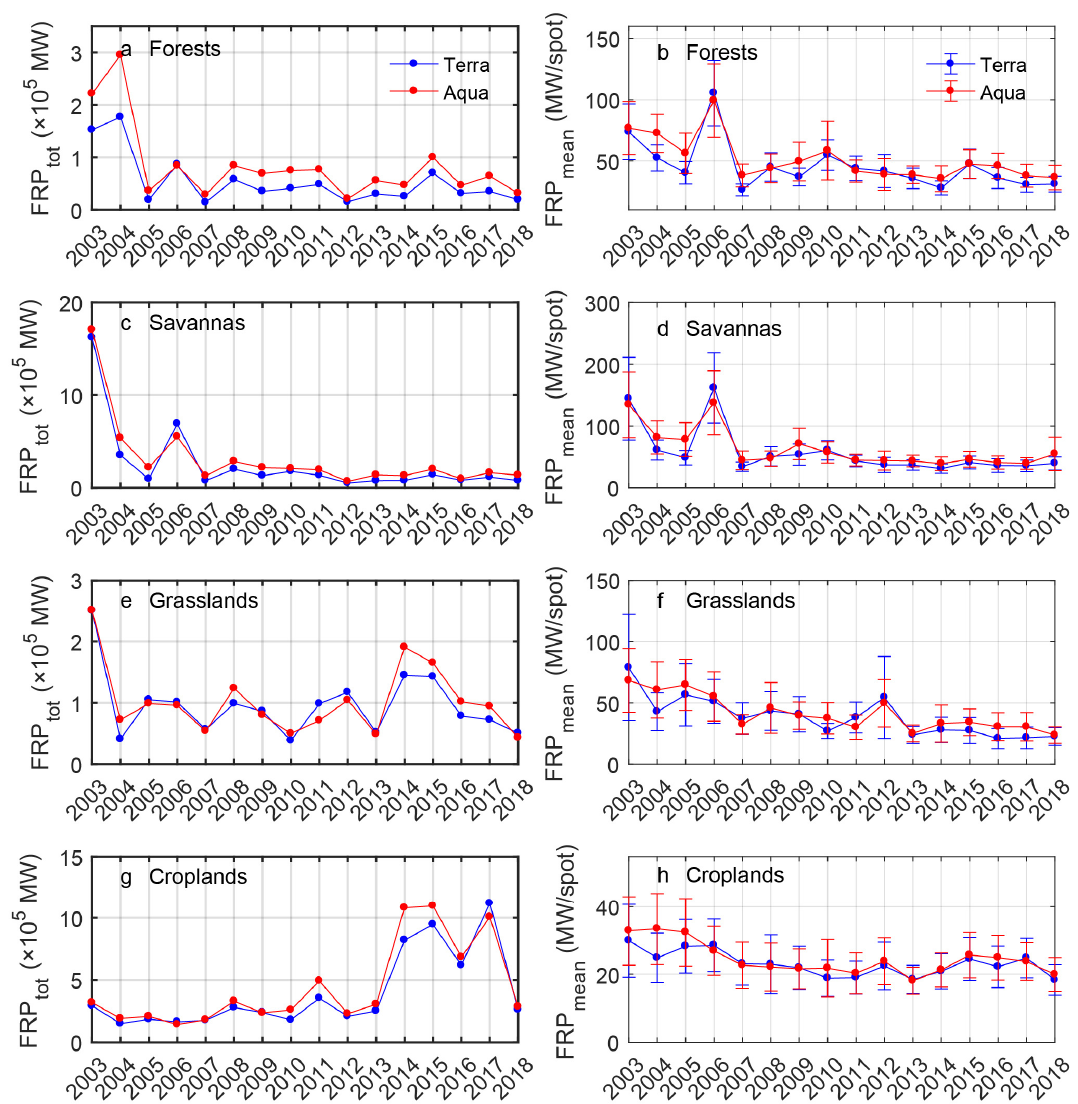
Figure 9. Annual total fire radiative power (FPR tot , left panels ) and mean fire radiative power for each fire point (FRP mean , right panels ) in different land cover types during 2003–2018 from Terra and Aqua fire products. The graphs show these values for ( a , b ) forests, ( c , d ) savannas, ( e , f ) grasslands, and ( g , h ) croplands. Error bars indicate one-fifth of the standard